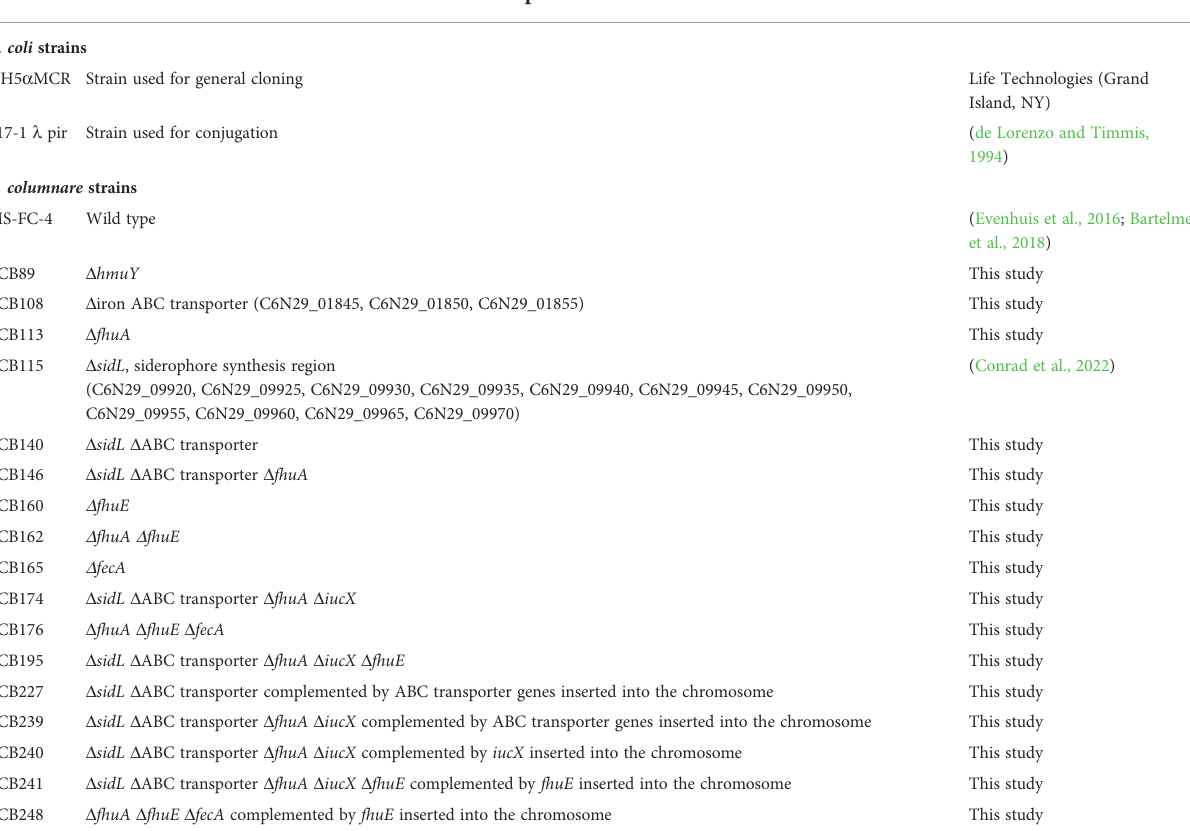
TABLE 2 Strains used in this